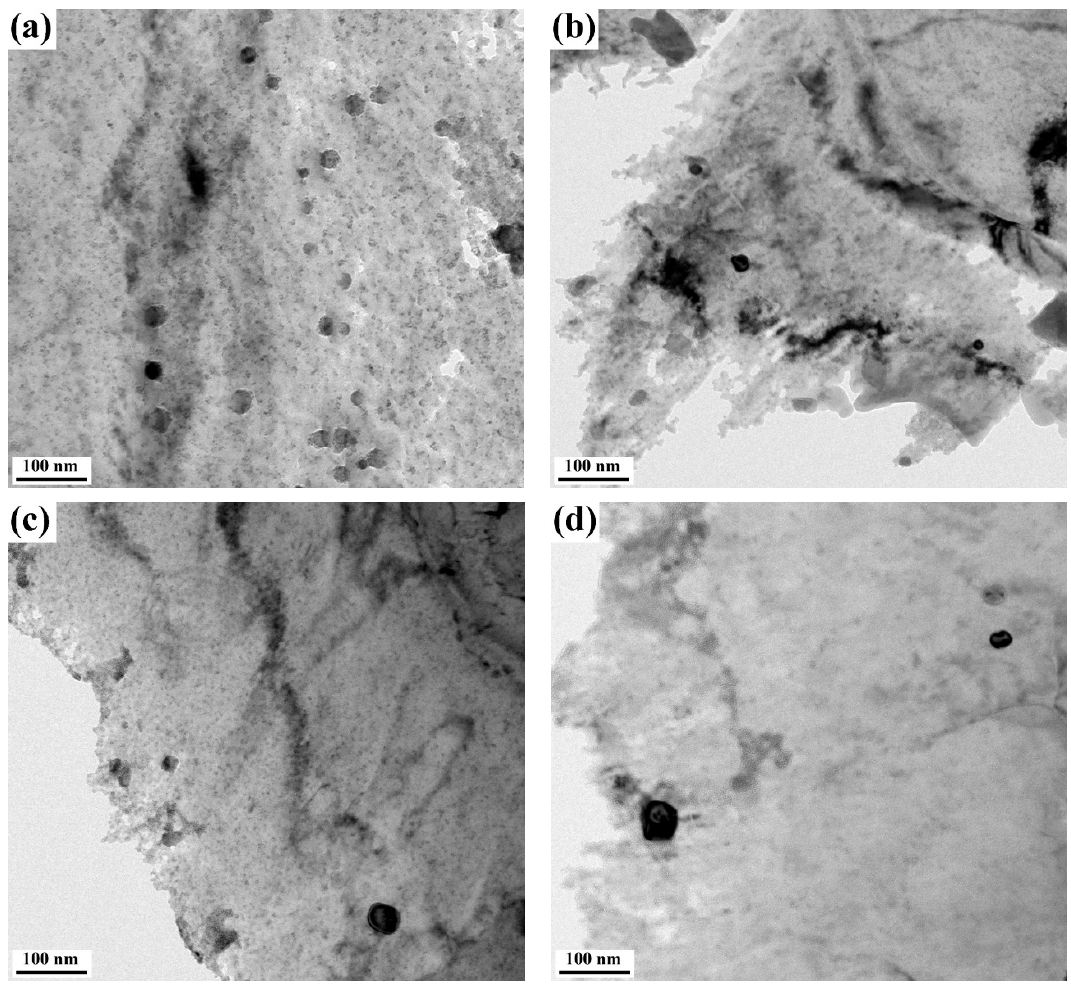
Figure 5. TEM morphologies of the precipitates in the samples heated to 1150 °C for different holding times, ( a ) 1 s, ( b ) 10 s, ( c ) 20 s, and ( d ) 40 s.